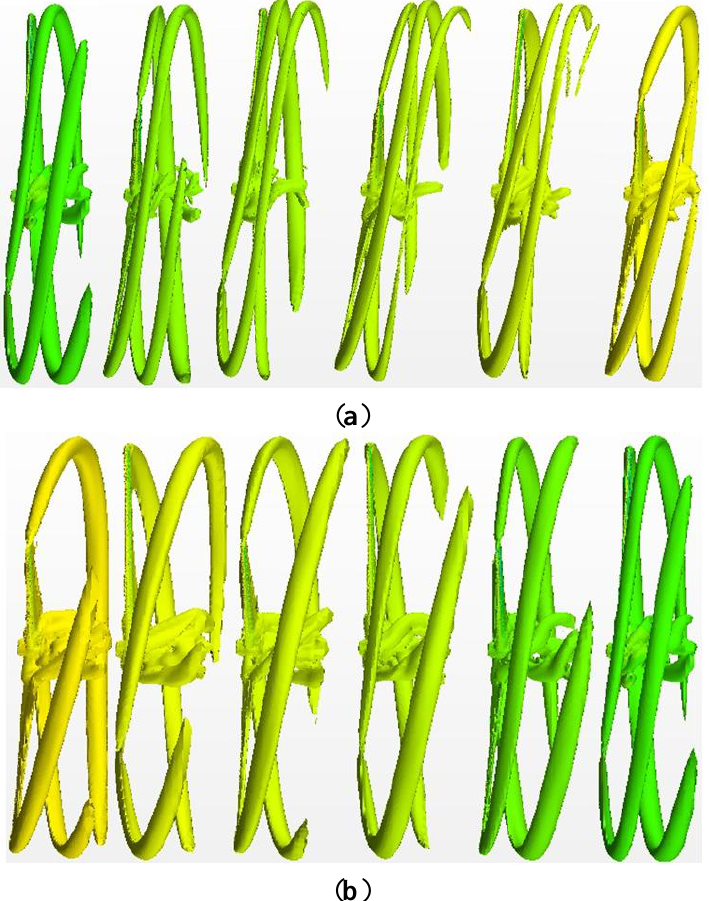
Figure 10. Visualisation of instantaneous computed vortices for unsteady pitching of a FOWT simulation represented by an isosurface of vorticity (Amp = 4°, Freq = 0.1